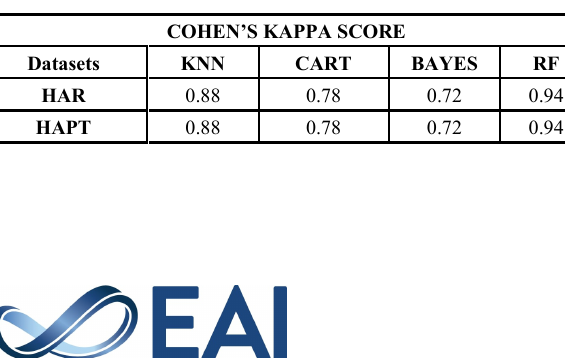
Table 6. Comparative analysis of Cohen’s Kappa Score as compared with proposed model